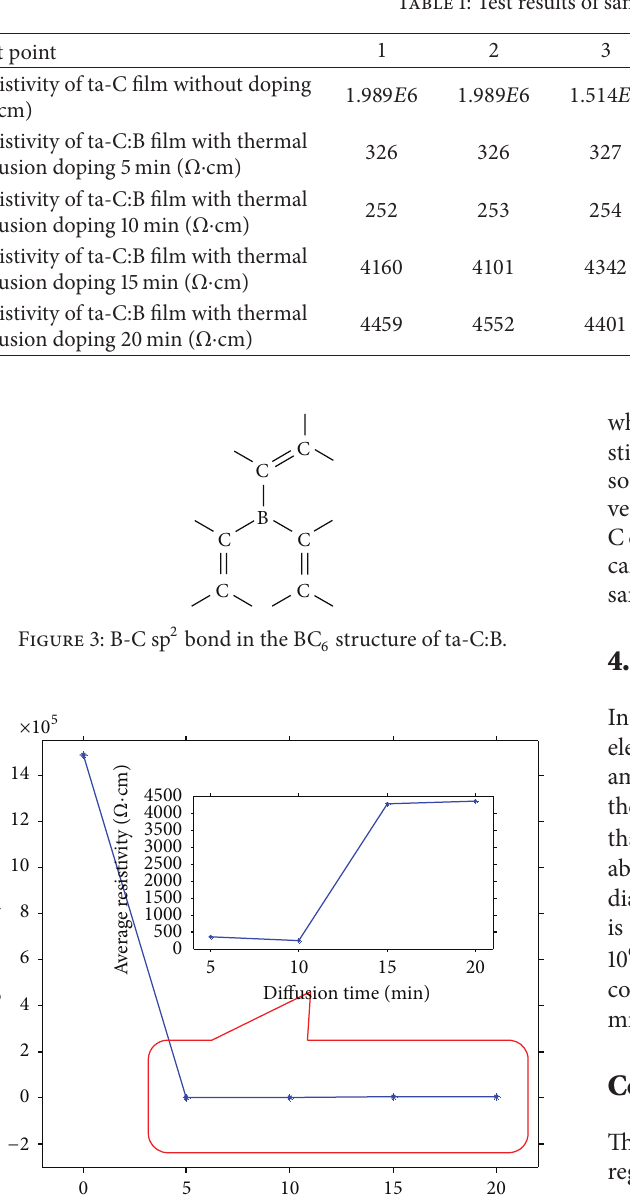
Table 1: Test results of samples’ resistivity.